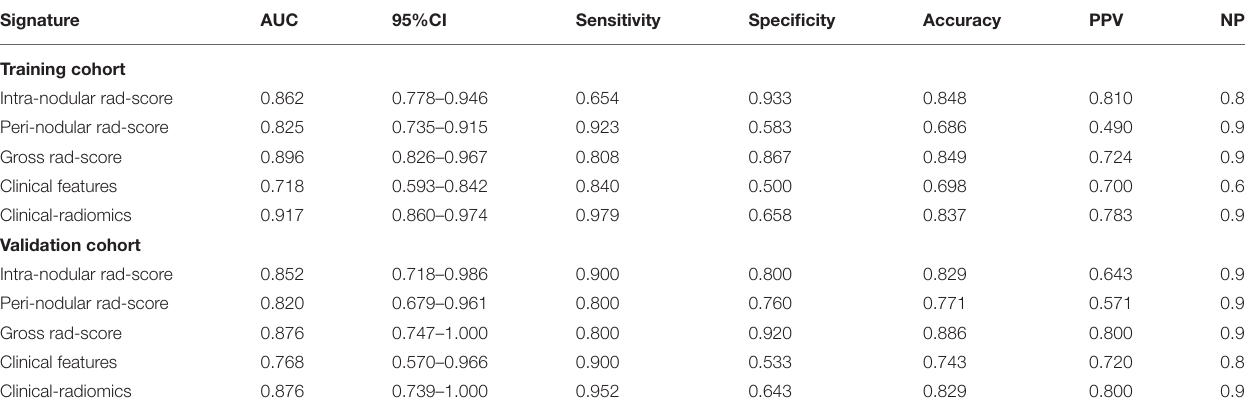
TABLE 2 | Predictive value between five different models in the training and validation